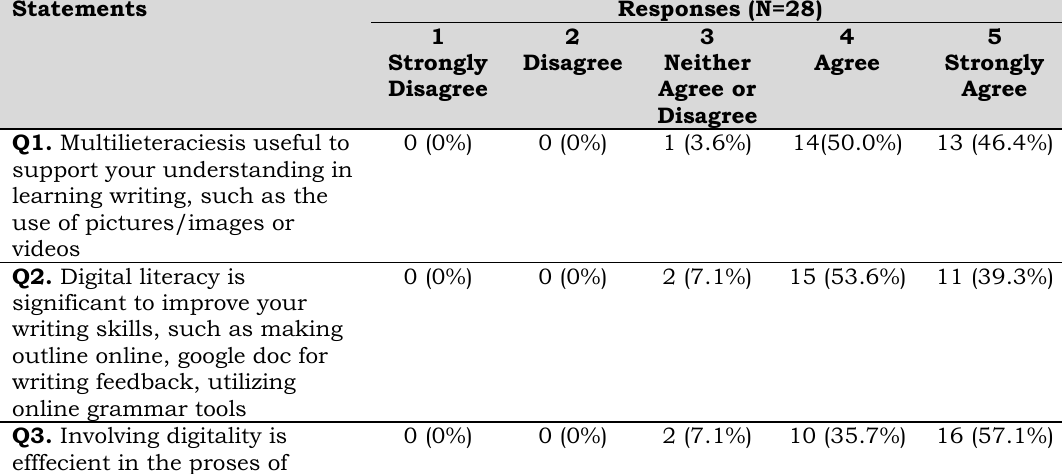
Table 2. PSTs’ perceptions of experiencing multiliteracies and process writing approach